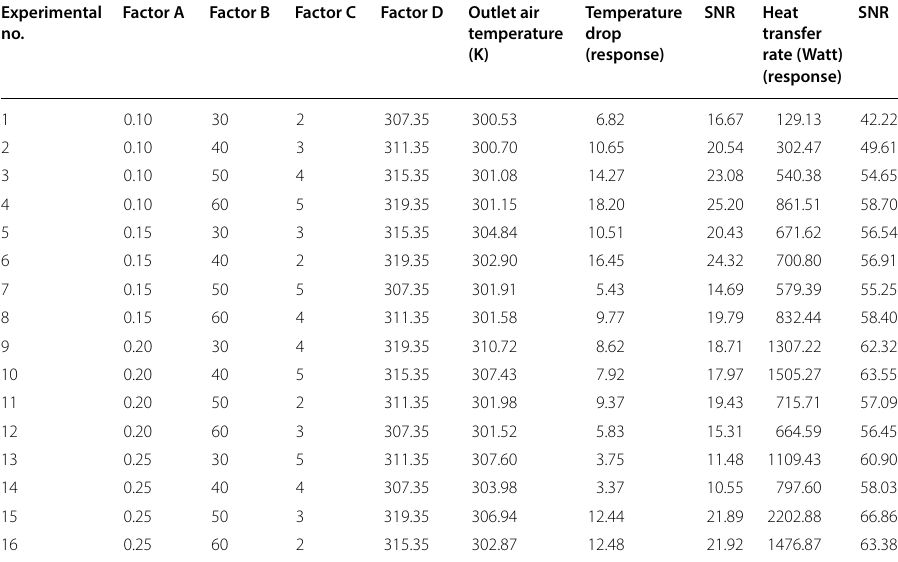
Table 4 Taguchi L16 experimental plan with corresponding temperature drop in air and S / N ratios Experimental no.